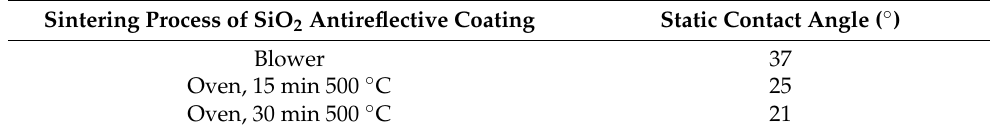
Table 7. Static contact angle values of Al/CuMnO x /CuFeMnO x /SiO 2 samples with different sinter- ing processes of the silica layer. The values are an average of four